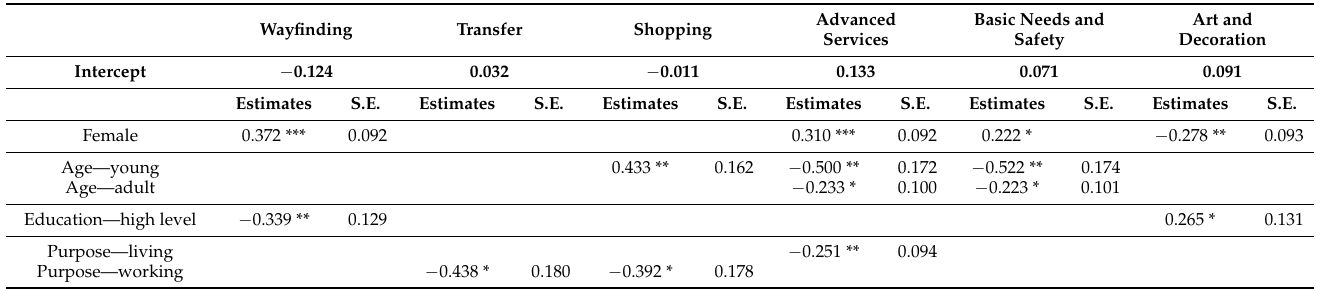
Table 7. Results of path analysis (only significant results